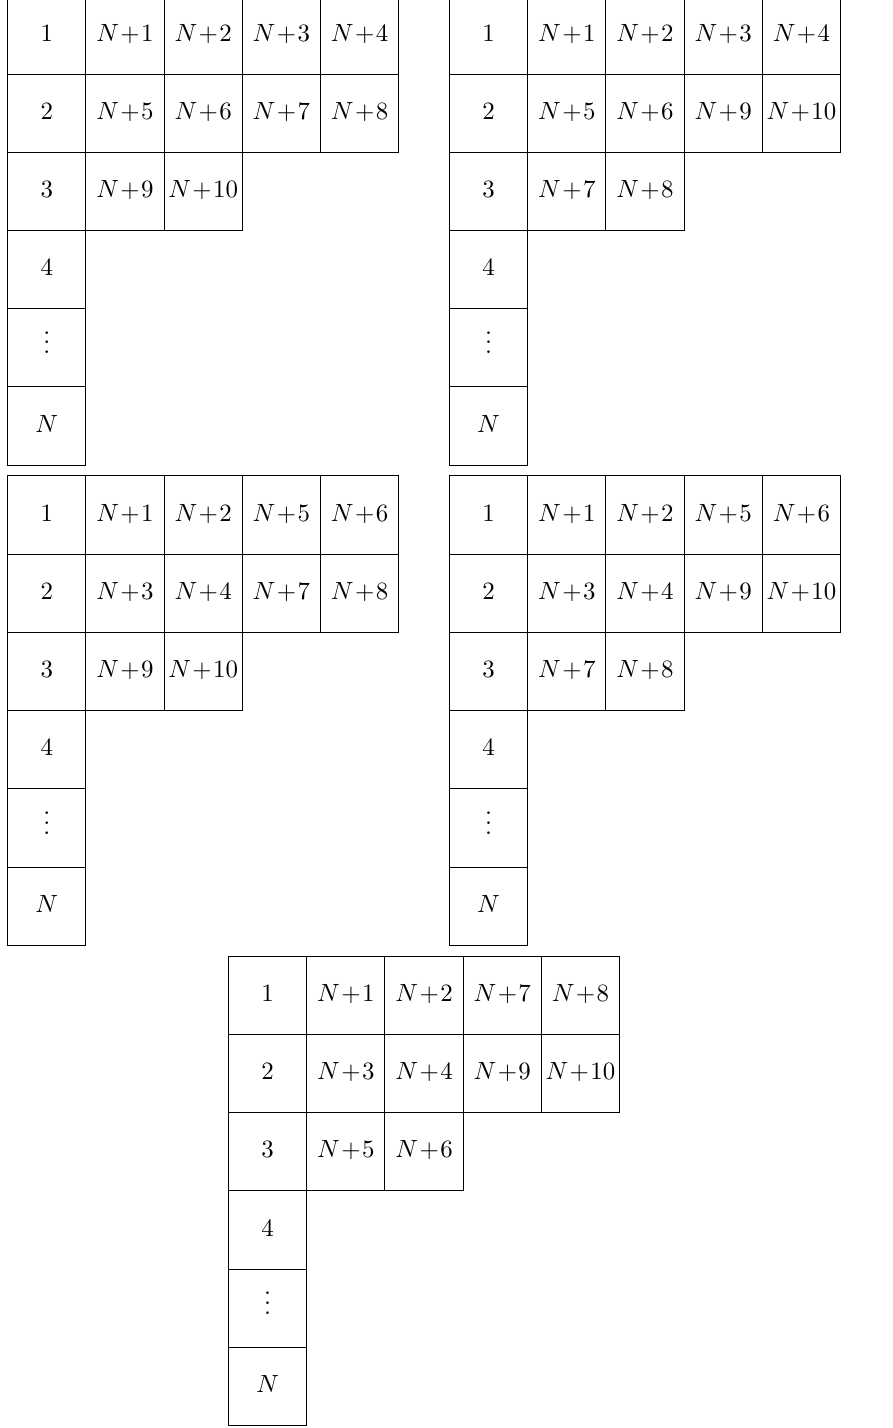
Figure 16 . The standard Young tableaux that contribute to the vector j 1 N + T i for T = [4 ; 4 ; 2].